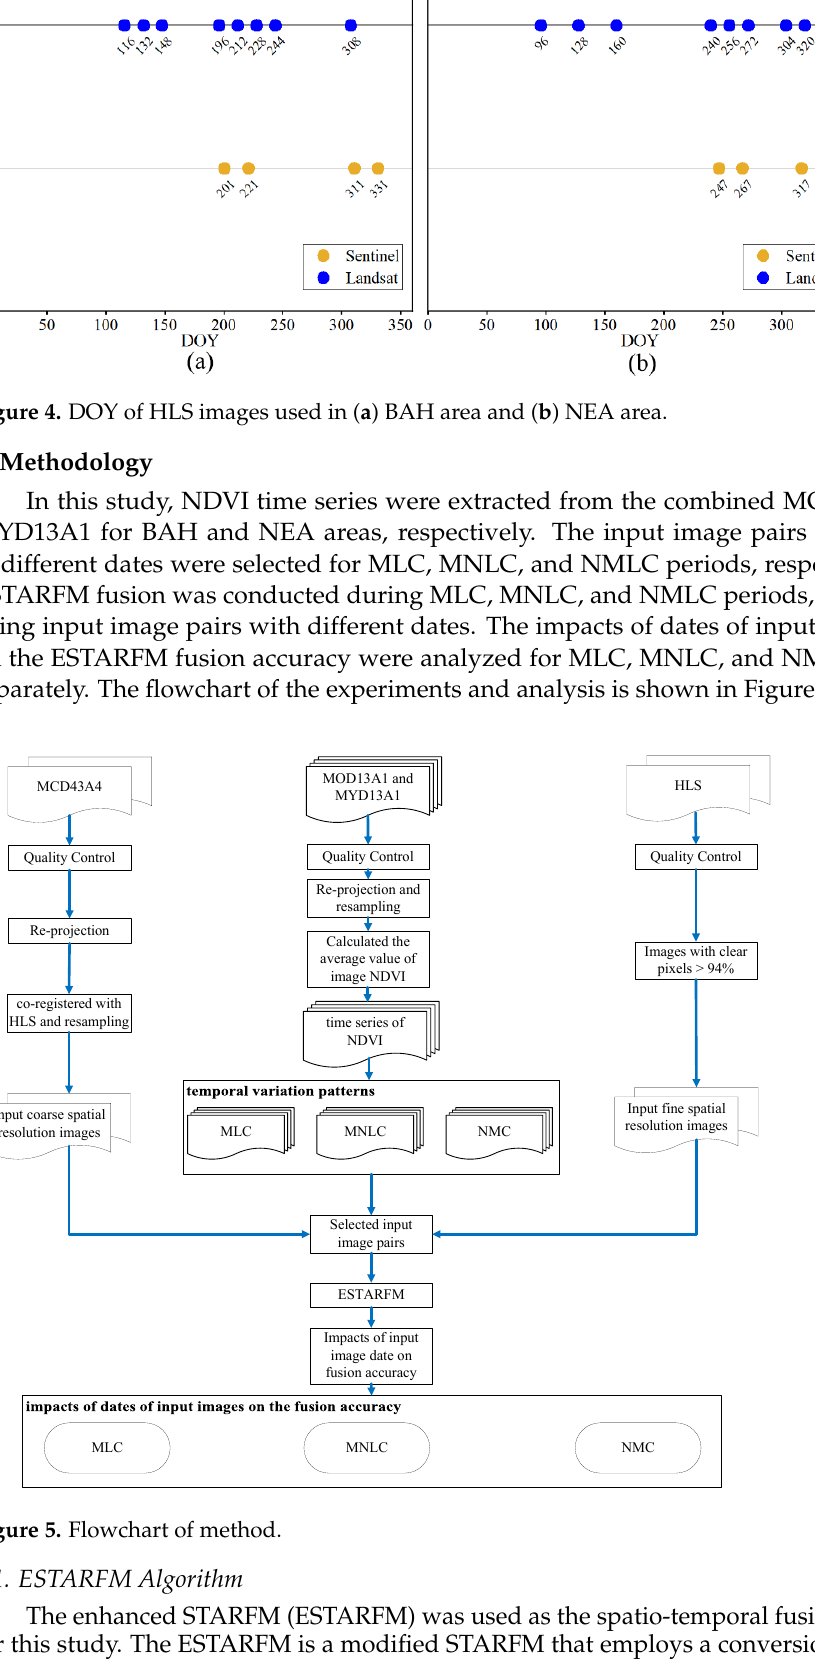
Figure 3. Temporal variation in the three sets of NDVI (Pointed out by vertical line). ( a ) MLC, ( b ) MNLC, and ( c ) NMC.